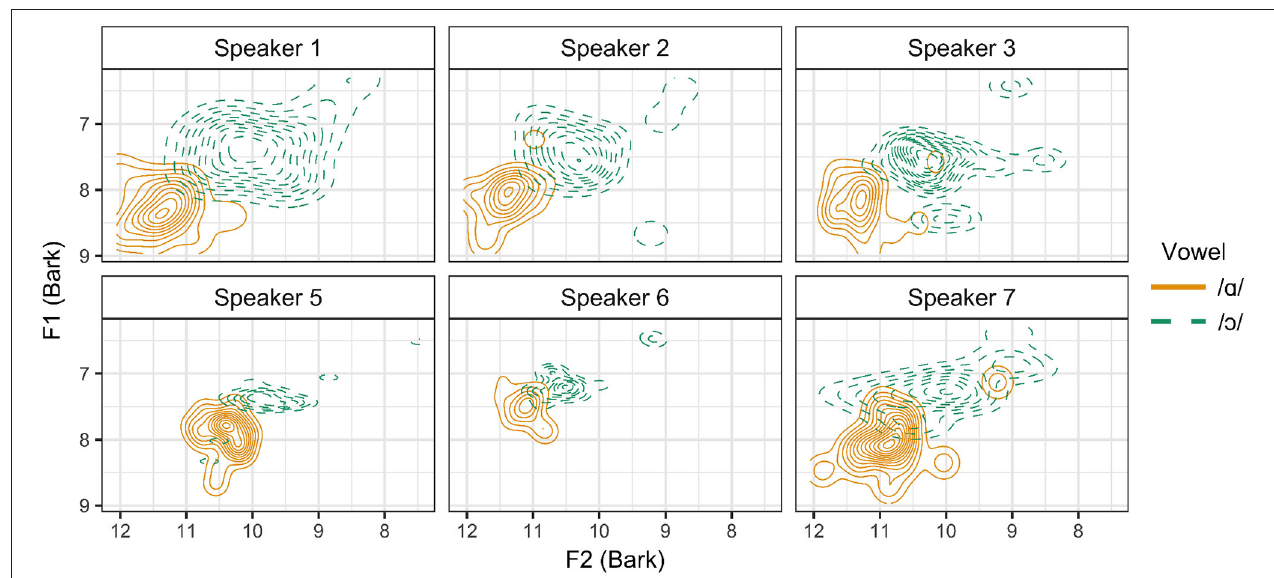
FIGURE 9 | Kernel density estimation plot of normalized, Bark-scaled vowel formant measurements for /A/ and /O/ for all speakers.